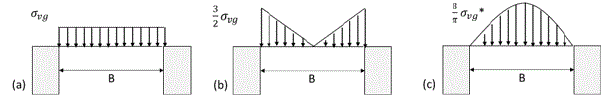
Figure 9. 2D stress distribution geometries (a) uniform, (b) inverse triangular and (c) parabolic. Table 1. Maximum deflection of the RG.